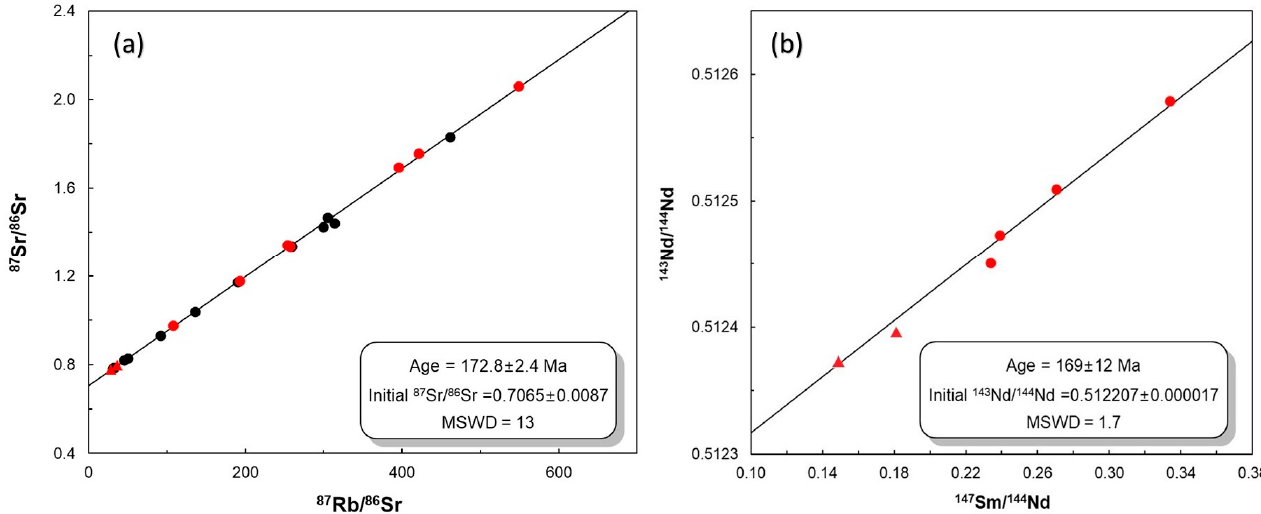
Figure 5. ( a ) Whole-rock Rb-Sr and ( b ) Sm-Nd isochrons for the Pirrit Hills granite; ● this study (B group); ▲ this study (A group); ● Millar and Pankhurst [27].